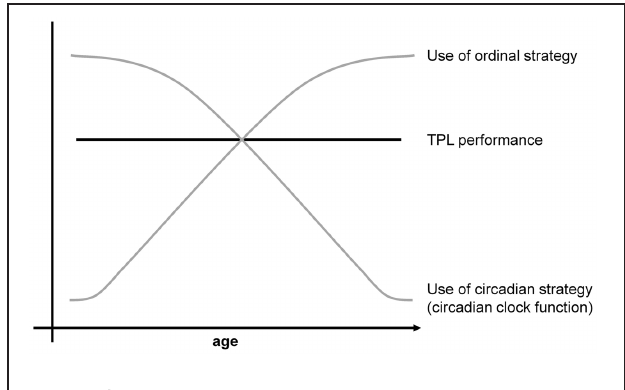
FIGURE 2 | Schematic representation of the strategy switching hypothesis with aging. Circadian system decline predicts that the circadian strategy becomes increasingly unreliable with age. To buffer performance loss, the ordinal strategy may gain dominance with aging as a reference to guide TPL